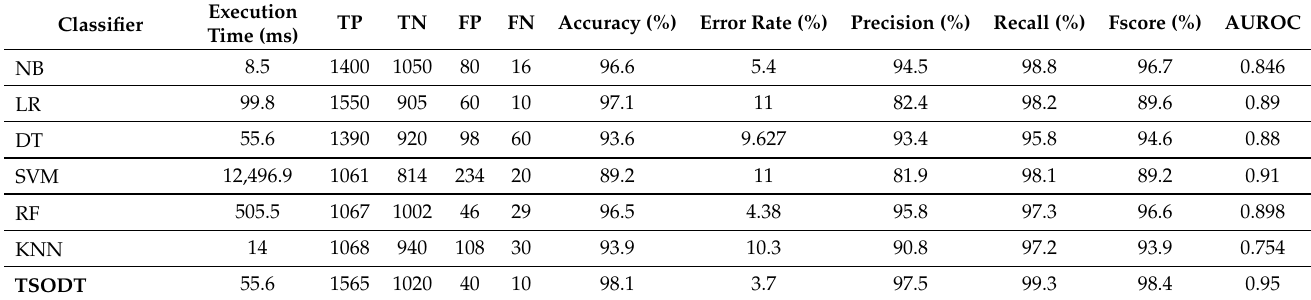
Table 2. Results and performance comparison to conventional state-of-the-art classifiers.